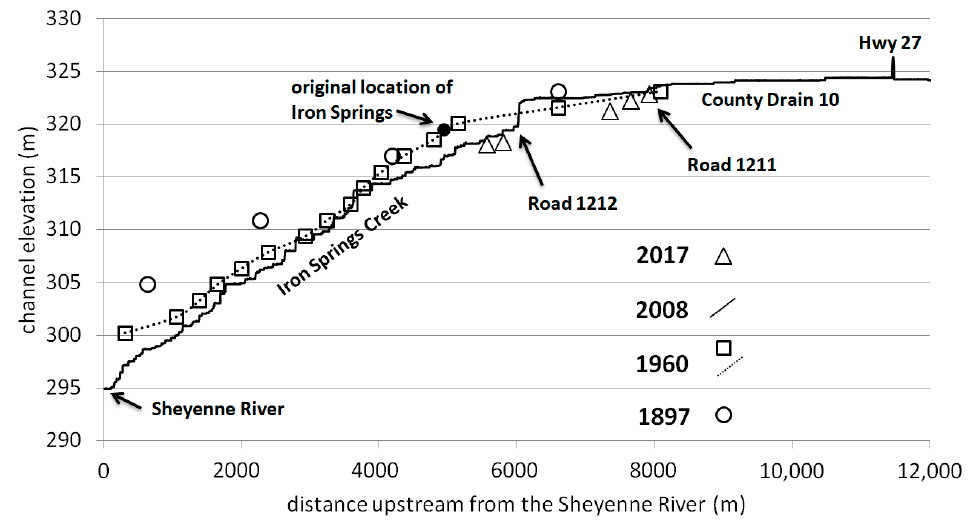
Figure 4. Longitudinal profile of Iron Springs Creek and Drain 10 between the confluence of the Sheyenne River (left) and North Dakota State Highway 27 (right). Channel elevations are based on topographic maps from 1897 / 1907 (Figure 2) and 1960, a 2008 regional LiDAR survey, and transect profile measurements made in